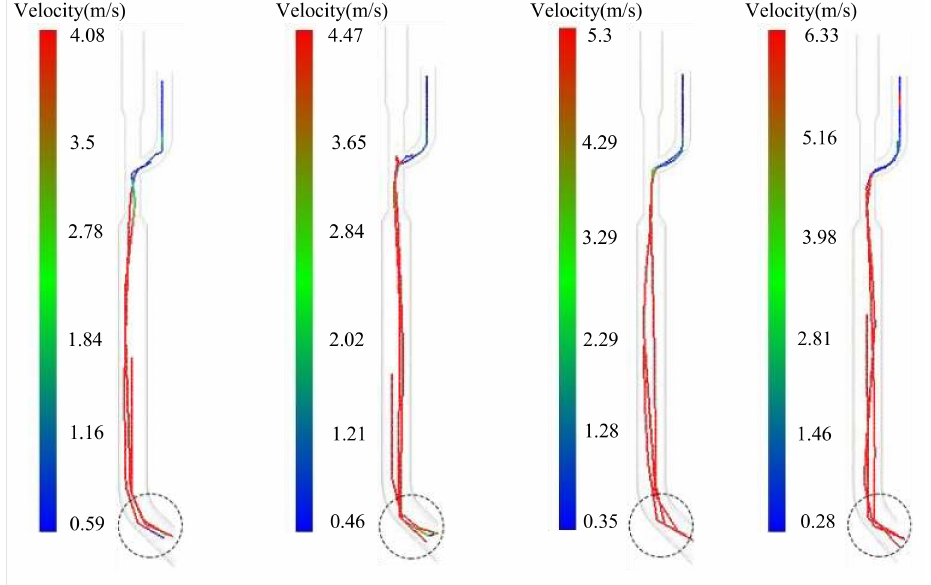
Figure 16. Particle motion track in the delivery device under different inlet-airflow